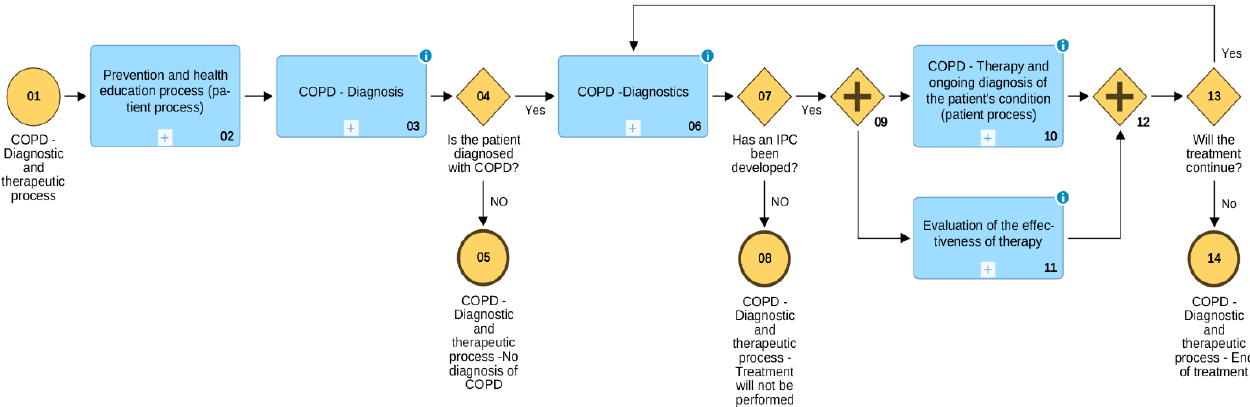
Figure 2. General map of the diagnostic and therapeutic process of COPD (by ADONIS).